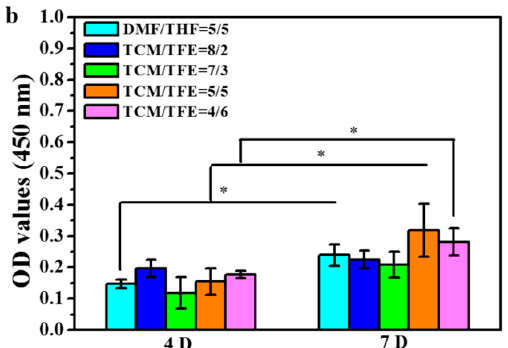
Figure 8. ( a ) SEM images of rMSCs cultured on electrospun TPU nanofiber meshes; ( b ) cell viability of rMSCs on TPU nanofiber scaffold at day 4 and day 7. * suggests these data were considered statistically significant ( p < 0.05).